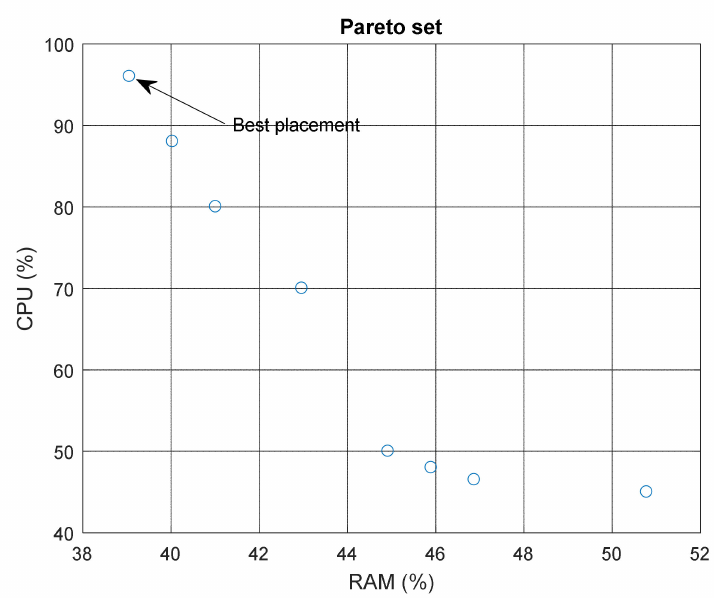
Figure 8. Pareto set of a simplified scenario. Table 4. The best service placement in a simplified scenario. Services